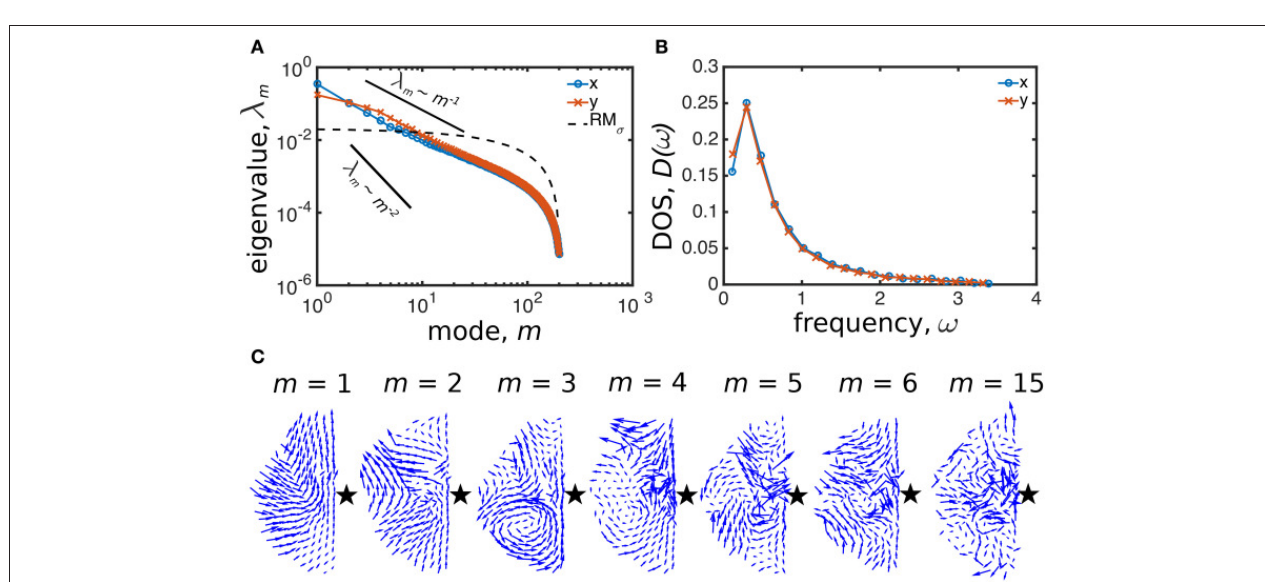
FIGURE 9 | Eigenmode analysis of asocial model for high-density human crowds. (A) Eigenvalue spectrum λ m of the displacement correlation matrix exhibits scaling m − 1 and m − 2 (black solid lines). Eigenmodes up to m properties between λ m 6 in both x (blue) and y (orange) directions are larger than the random matrix ∼ ∼ = model ( RM σ , dashed line), thus they are named “soft modes” and describe correlated motion. (B) The DOS exhibits a Bosonic peak in both the x and y components, indicating mechanical instability. (C) Soft mode vector fields for run 1 ( m 1 to 6) are more spatially correlated than a mode below RM σ ( m =